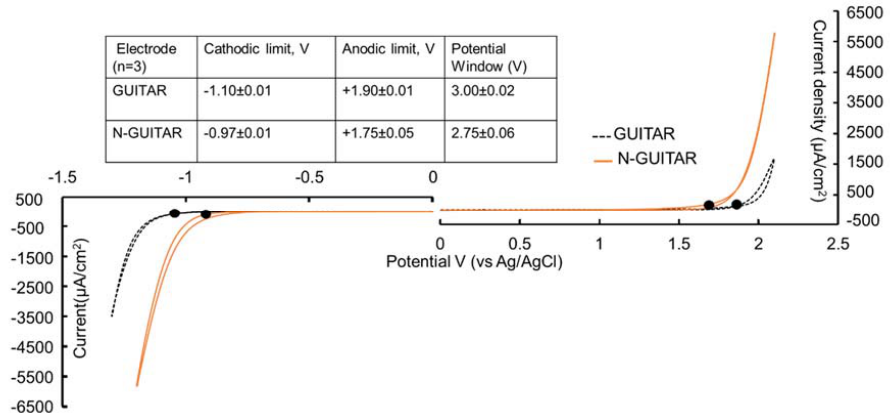
Figure 6. Cyclic voltammetric behavior of GUITAR (dashed line) and N-doped GUITAR (solid line) in 1 M H 2 SO 4 taken at 50 mV / s. The starting potential for both anodic ( right ) and cathodic ( left ) sweeps is 0.0 V. The 200 µ A / cm 2 potential limits are indicted with black dots and the potential windows are listed in the table inset.